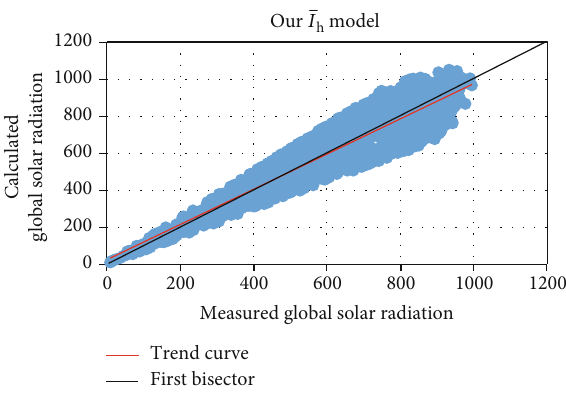
Figure 4: Graphical representation of the estimated values according to the measured values for various models to estimate (cid:1) I (cid:1) I between our h model (a) and Collares-Pereira and Rabl model (b).